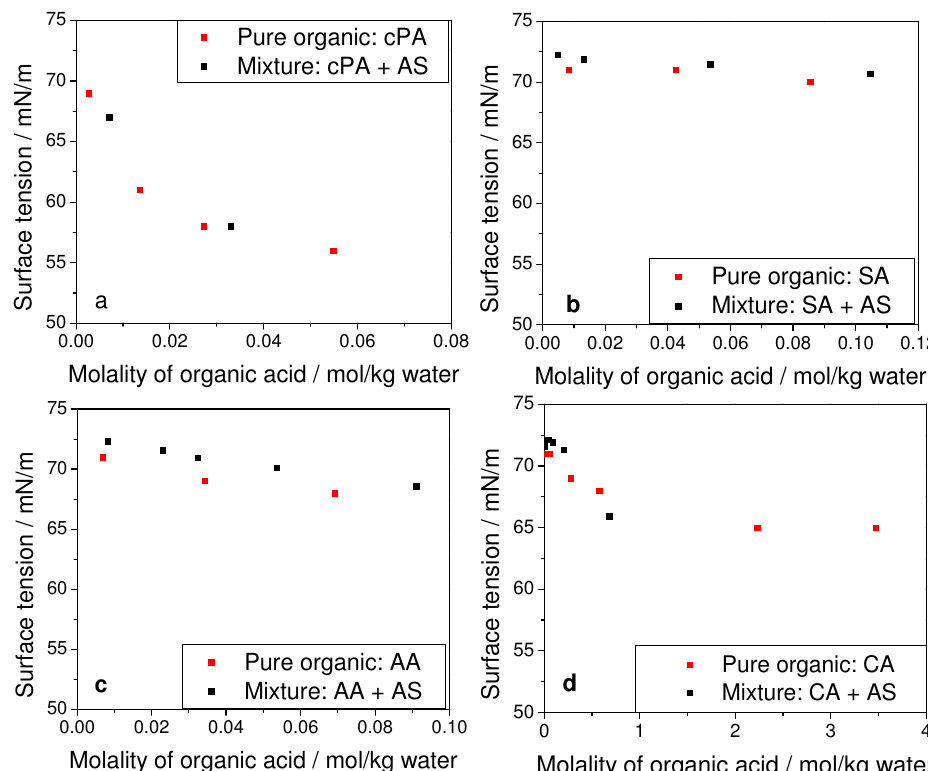
Fig. 2. Measured surface tension for four of the studied 50:50 mixtures (abbreviations are explained in Table 1). The data is depicted as a function of molality of the organic compound in aqueous solution. The data for pure organic acids is obtained from Varga et al. (2007).